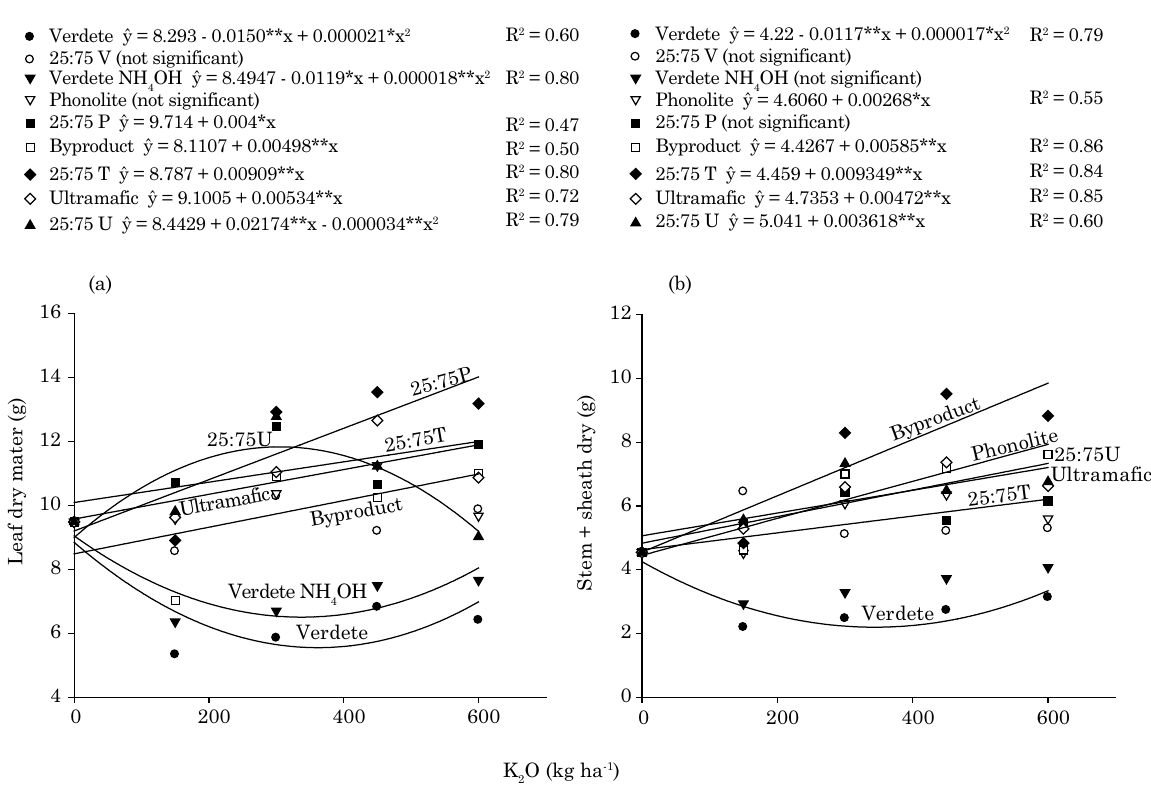
Figure 6. Dry matter of: (a) leaves, and (b) stem + sheath as affected by the treatments 60 days after planting.